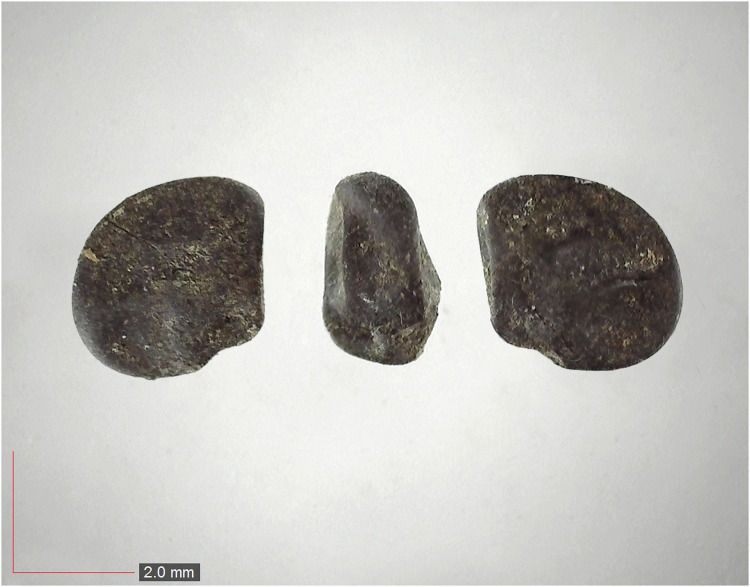
Unidentified 5.Table 2.